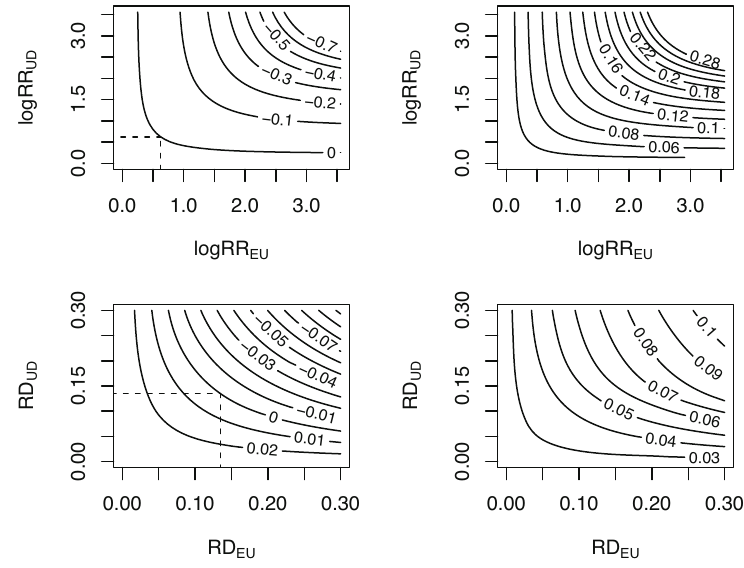
Figure 1: Top row: The DVS lower ( left panel ) and upper ( right panel ) bounds for the causal risk di ff erence, as functions of log RR EU and log RR UD . Bottom row: The SH lower ( left panel ) and upper ( right panel ) bounds for the causal risk di ff erence, as functions of RD EU and RD UD . The E - values are indicated by the dashed lines in the left